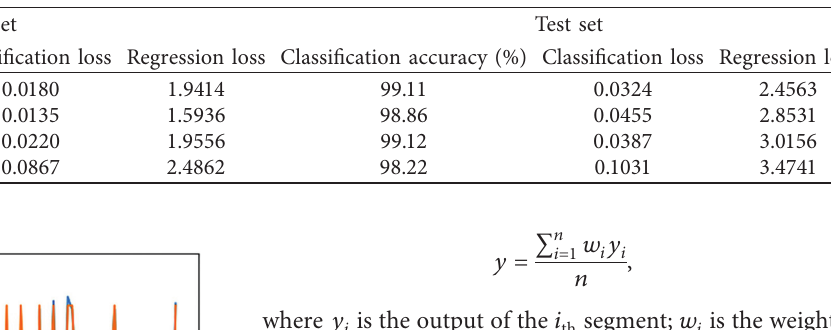
Table 2: Training and testing results of different data sets.